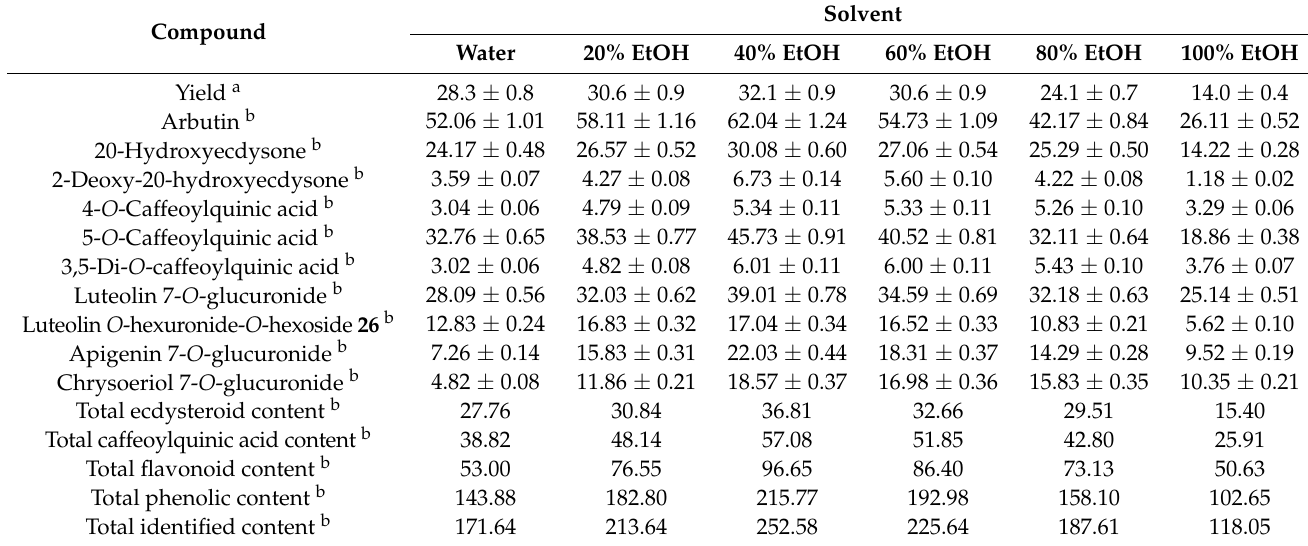
Table 2. Yield and content of ten compounds in K. centauroides leaf